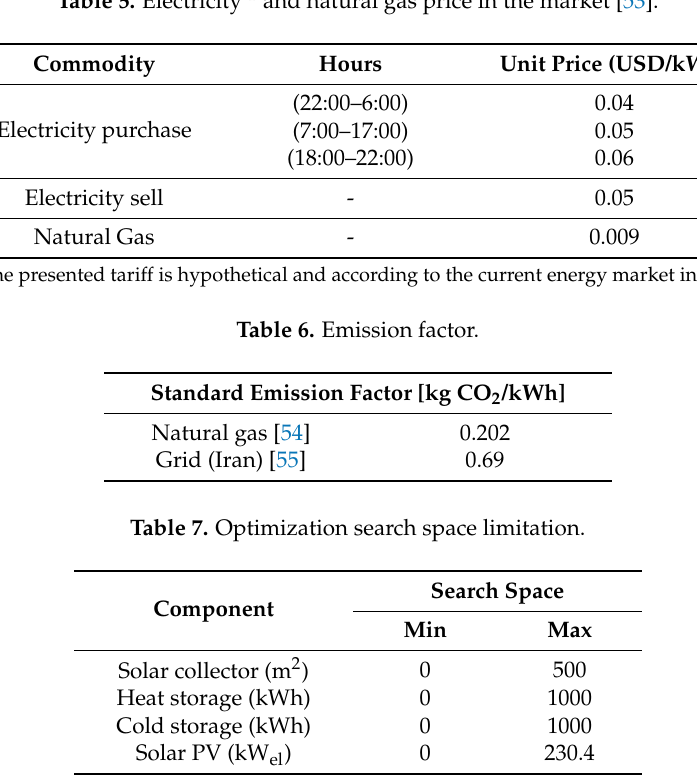
Table 5. Electricity 1 and natural gas price in the market [53].